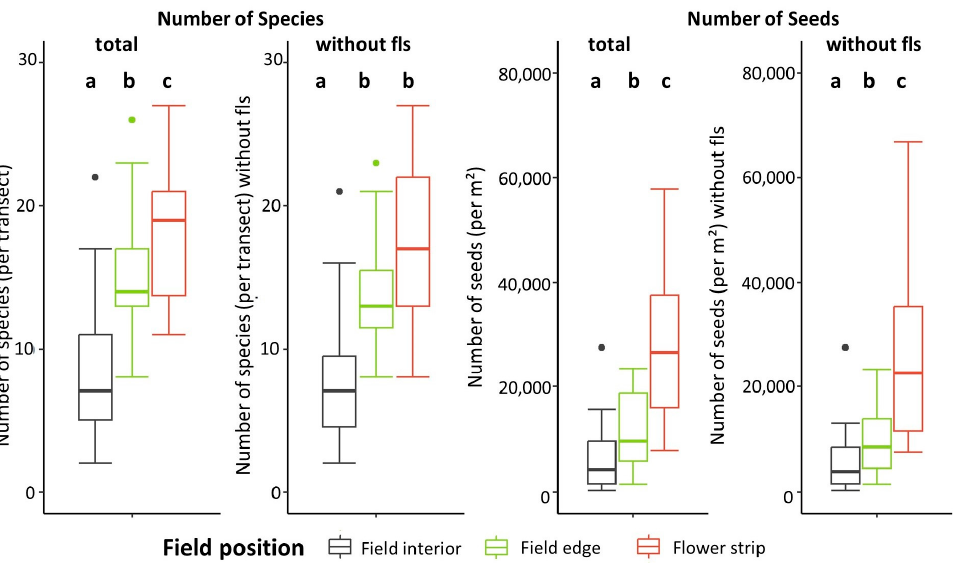
Figure 6. Boxplots of the number of species and seeds (with and without species sown with fl ower strip seed mixture, fl s) found in the seed bank in fl ower strips (red), fi eld edges (green), and fi eld strip seed mixture, fls) found in the seed bank in flower strips (red), field edges (green), and field interior (dark grey) (n = 19). Signi fi cant pairwise di ff erences are indicated by di ff erent le tt ers (pair- interior (dark grey) (n = 19). Significant pairwise differences are indicated by different letters (pairwise wise comparisons, p -value ≤ 0.05, Tukey-corrected). comparisons, p -value ≤ 0.05,